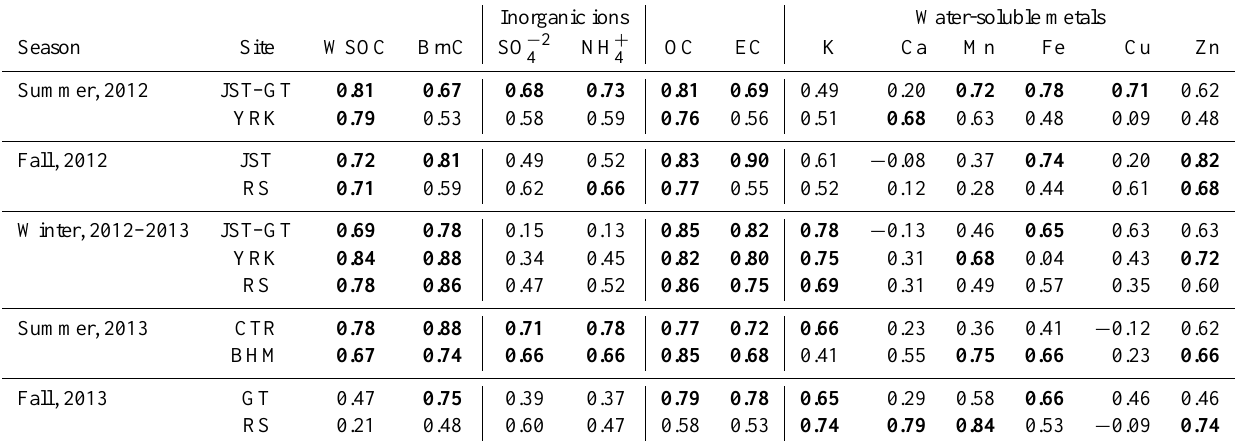
Table 2. Regression analysis (Pearson’s R ) between DTT activity and selected PM components. Inorganic ions Water-soluble